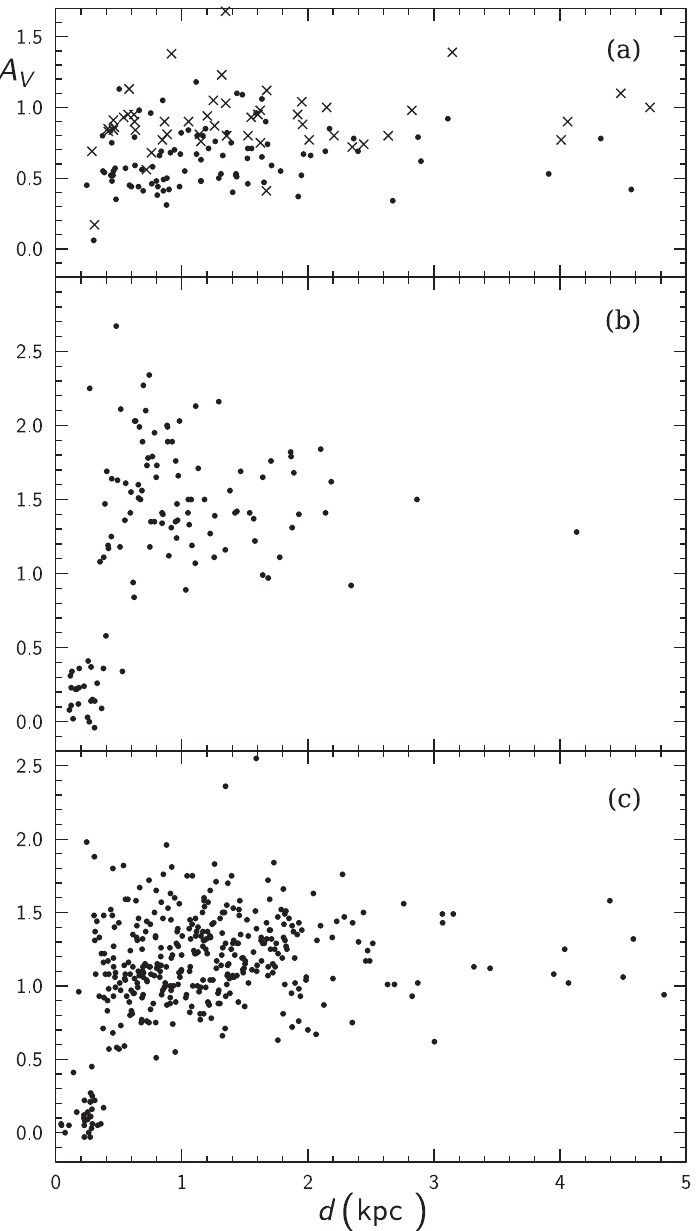
Fig. 3. Dependence of the extinction A V on distance for the areas delineated in Figure 1: (a) – two most transparent subareas (dots for T 1 and crosses for T 2 ), (b) – the darkest subarea D, (c) – the remaining stars of the